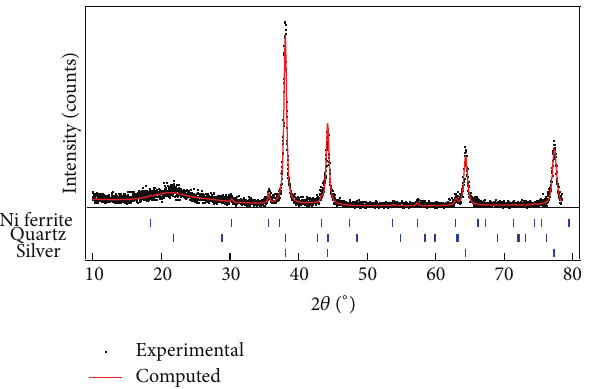
Figure 5: X-ray diffractogram and Rietveld refinement of Ni 1.43 Fe 1.7 O 4 -SiO 2